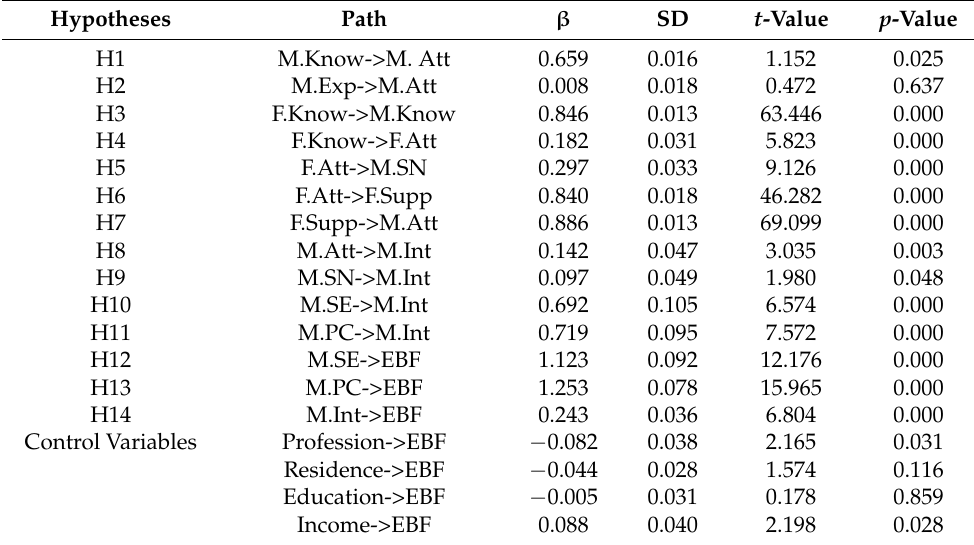
Table 6. Path coefficients of structural equation modelling (SEM) (using complete